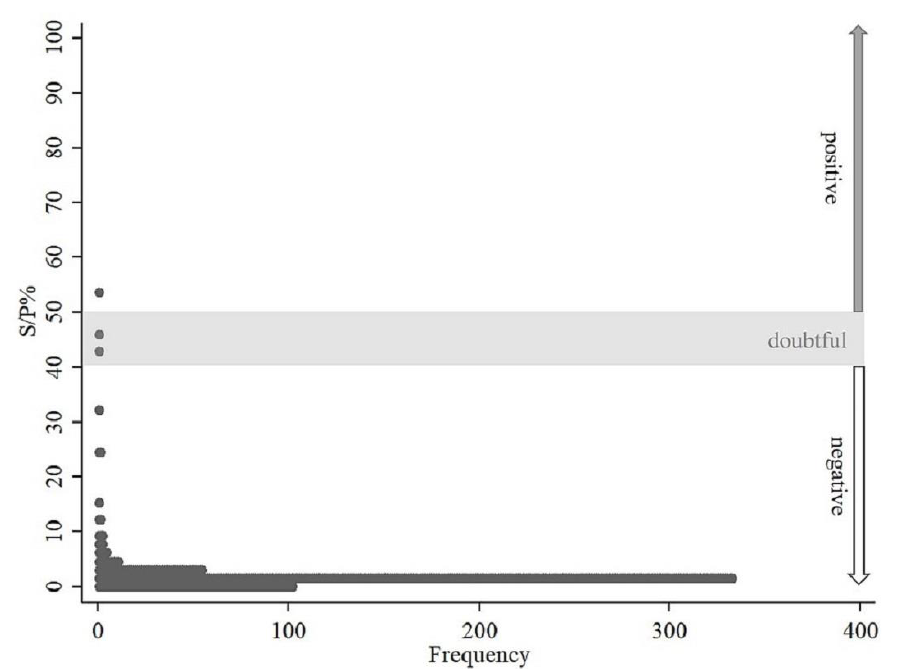
Figure 2. Dotblot distribution of Sample to Positive percentage (S/P%) values of ID Screen Q Fever Indirect Multi-species (IDvet, Grabels, France) testing for the presence of Coxiella burnetii antibodies in 523 sera of European bison ( Bison bonasus ) collected between 2013 and 2018 in 14 different locations in Poland.